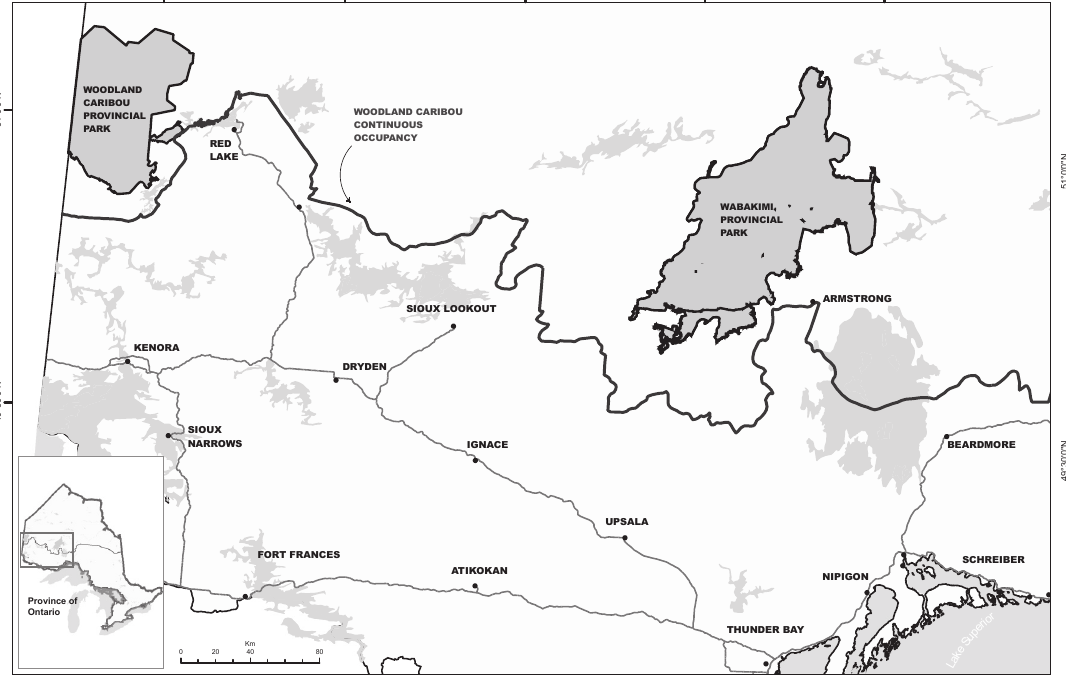
Fig. 1. Locations of Wabakimi and Woodland Caribou Provincial Parks in relation to the southern limit of continuous range occupancy of woodland caribou ( Rangifer tarandus caribou ) in northern